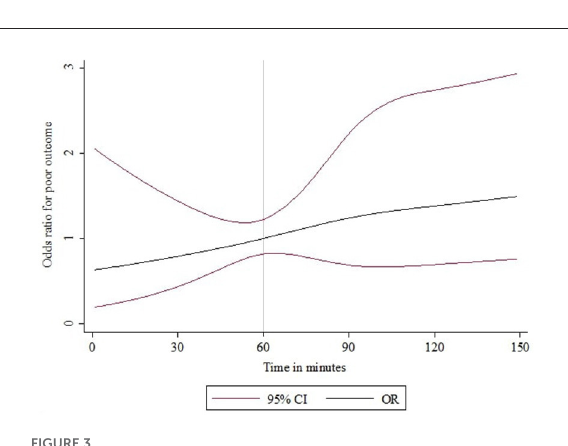
FIGURE3 IVT-ET time delay and binary OR for “poor” functional outcome (mRS > 2) at 90 days after acute ischaemic stroke. The time delay between IVT and ET was modeled as a continuous exposure variable using splines and the odds ratio estimates are for a “poor” functional outcome (mRS 3–6). An IVT-ET time delay of 60 elapsed minutes was used as the